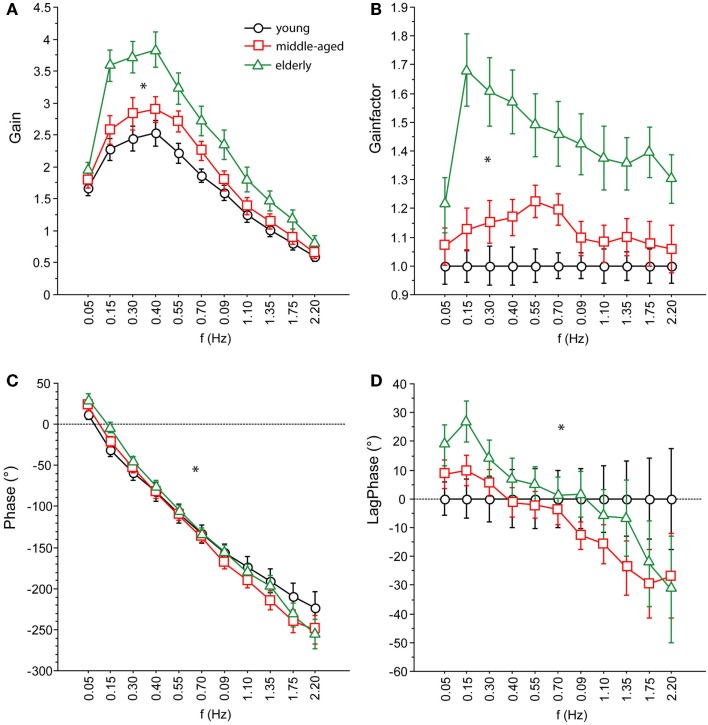
Parameters of perturbed stance. (A) GAIN, (B) GAINFACTOR, (C) PHASE, (D) LAGPHASE of the three age groups across all stimulus amplitudes and visual conditions. GAINFACTOR is the percental quotient between the GAIN of the middle-aged and elderly group and the young group as a comparison group. The time difference between PHASE of the middle-aged and elderly group and the young group as a comparison group is named LAGPHASE. Its unit is degrees (°).